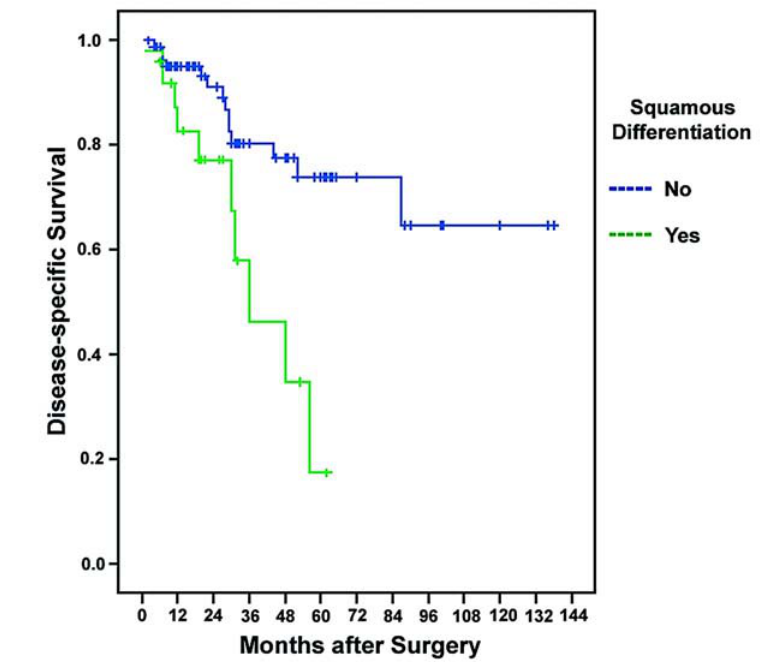
Figure 3 – Cancer-specific survival among patients with and without squamous differentiation (log-rank test; p =